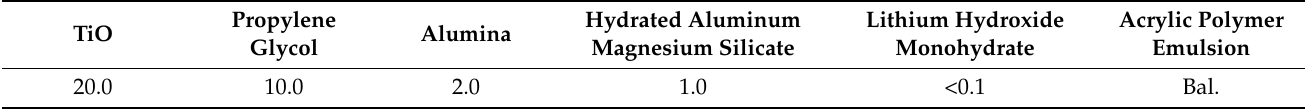
Table 2. Composition of waterborne acrylic coating